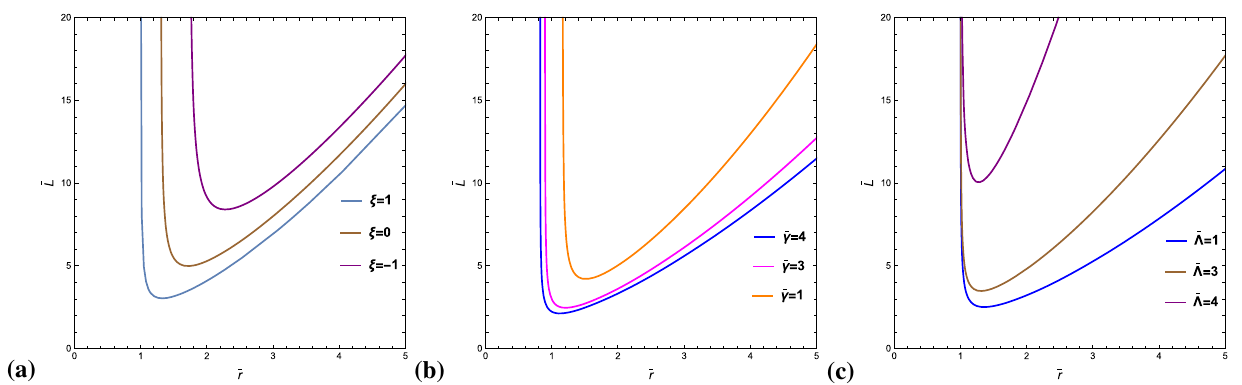
Fig. 4 The graphs show the specific angular momentum ¯ L to ¯ r for the particles moving around the black hole and making the thin accretion disk. a Different values of ς with considering ¯ γ = 2 and ¯ Λ = 2. b Different values of ¯ γ with considering ς = 1 and ¯ Λ = 2. c Different values of ¯ Λ with considering ς = 1 and ¯ γ = 2